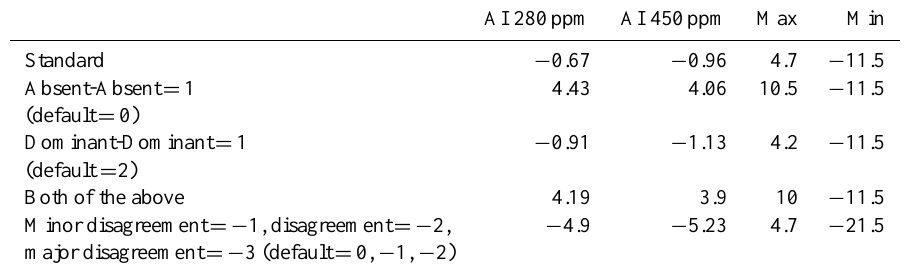
Table E1. Overall agreement index (AI) scores for the 280 and 450ppm Tortonian runs, as well as the minimum and maximum values calculated with different scores assigned for levels of agreement.